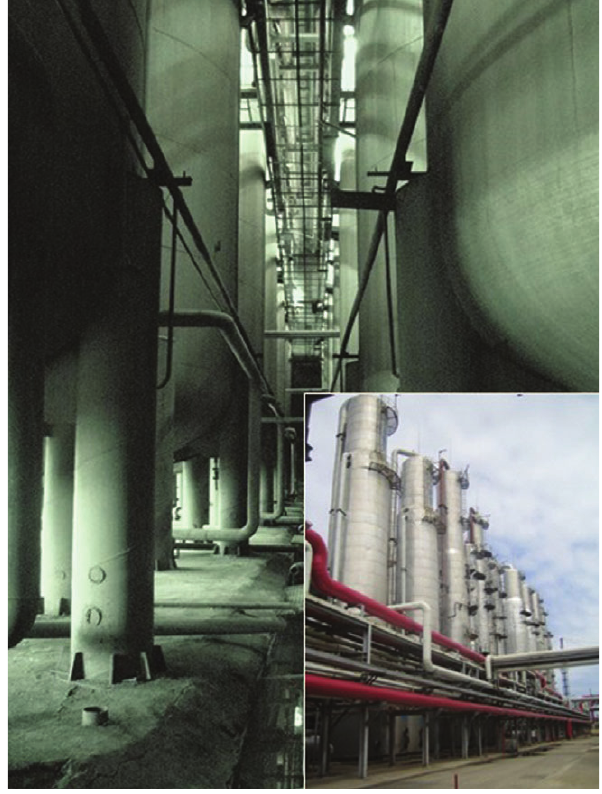
Figure 2 Modern ABE plant in Jilin, China; bioreactors and purification (inset).